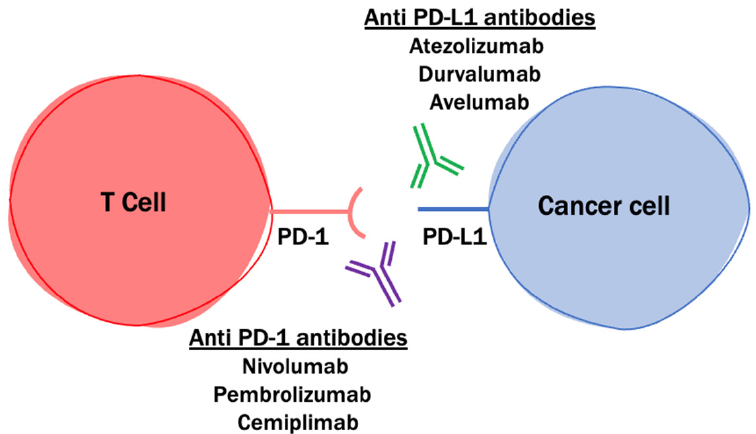
Figure 2. PD-1 and PD-L1 expression. PD-1 (programmed death-1) and PD-L1 (programmed death ligand 1) are expressed in T cell and cancer cells, respectively. Examples of PD-1 blockers include nivolumab, pembrolizumab, and cemiplimab. Examples of PD-L1 blockers include atezolizumab, durvalumab, and avelumab. Table 3 . Immune checkpoint inhibitor clinical trials for GBM.